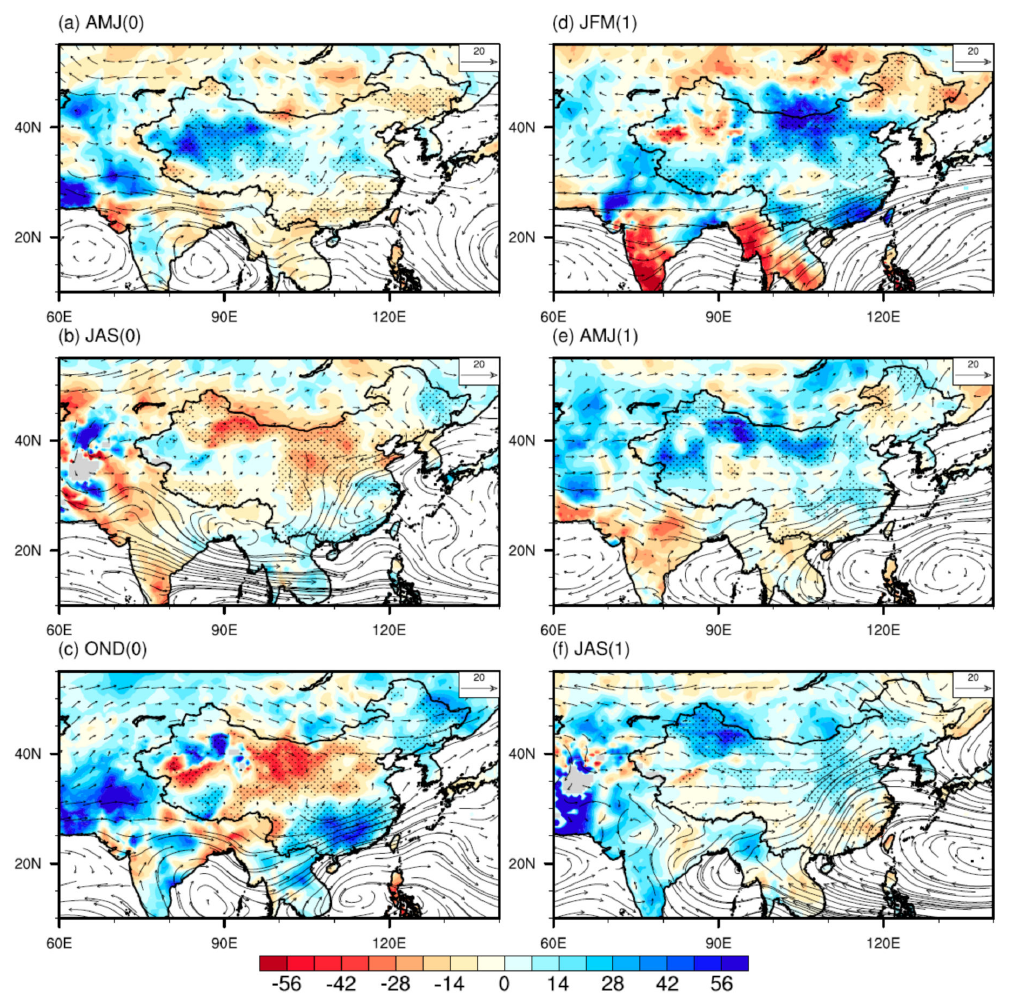
Figure 7. Same as in Figure 3, but for combined years. In these years, the Indian Ocean Dipole and the El Nino simultaneously occurred. Shown are during ( a ) April to June (AMJ(0)), ( b ) July to September (JAS(0)), and ( c ) October to December (OND(0)) in the developing phase, and the following ( d ) January to March (JFM(1)), ( e ) April to June (AMJ(1)), and ( f ) July to September